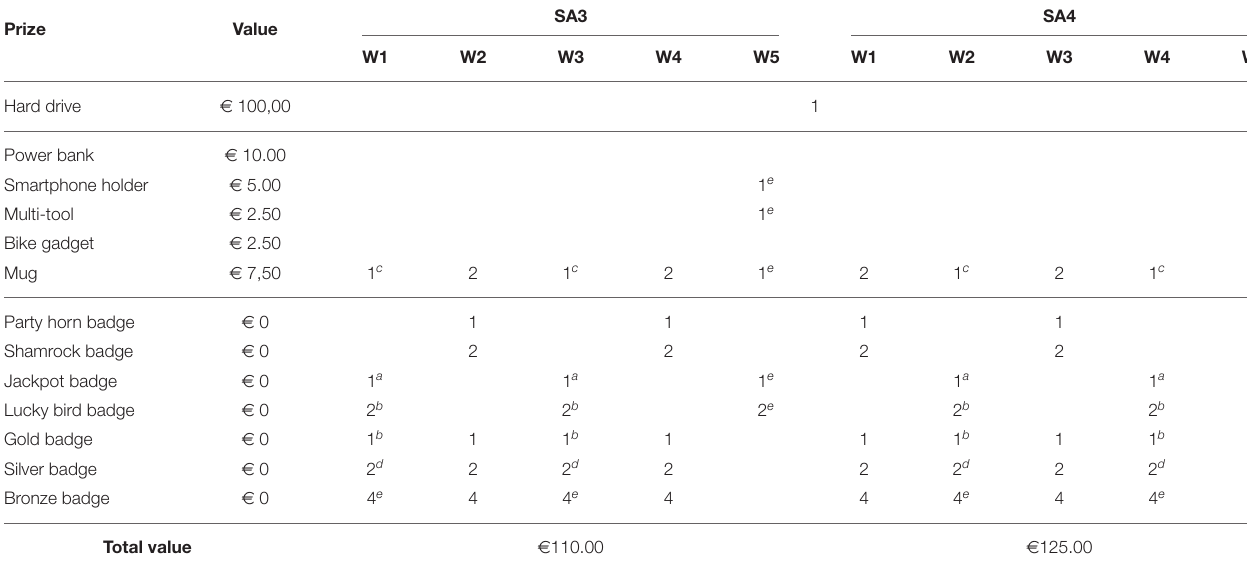
TABLE 3 | Overview of rewards per wave for the long-term, high-value payout schedule.